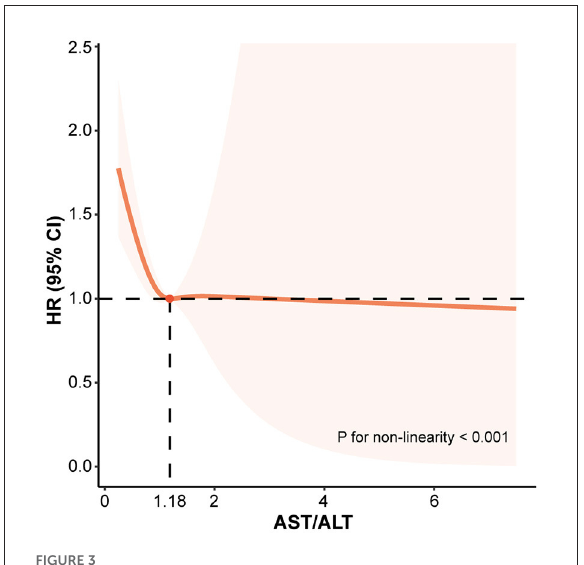
FIGURE3 The association between ASL/ALT (DeRitis) ratio and the risk of diabetes assessed by restricted cubic splines analysis. ALT, alanine aminotransferase; AST, aspartate transaminase; CI, confidence interval; HR, hazard